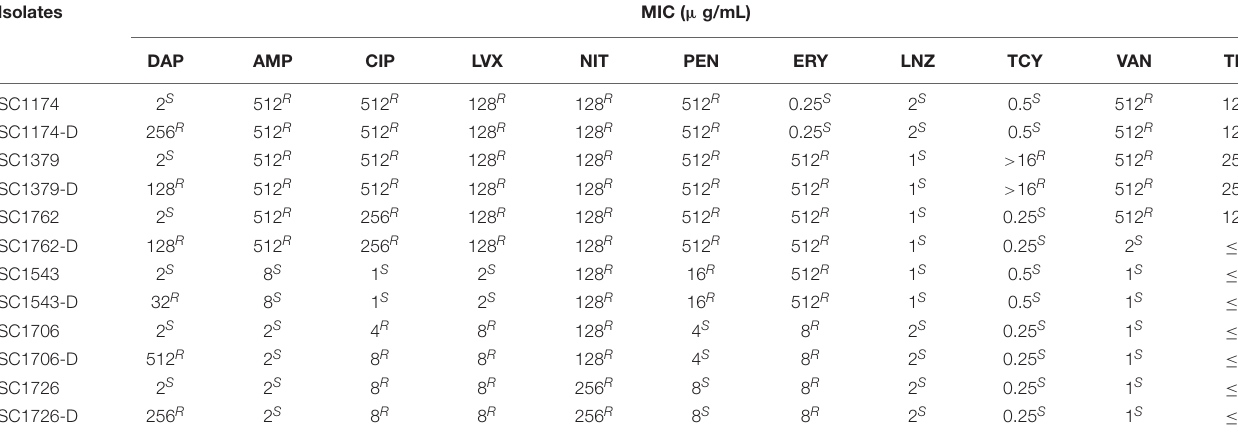
TABLE 1 | Activity of daptomycin and other antibiotics against parental and mutant strains of Enterococcus faecium. Isolates